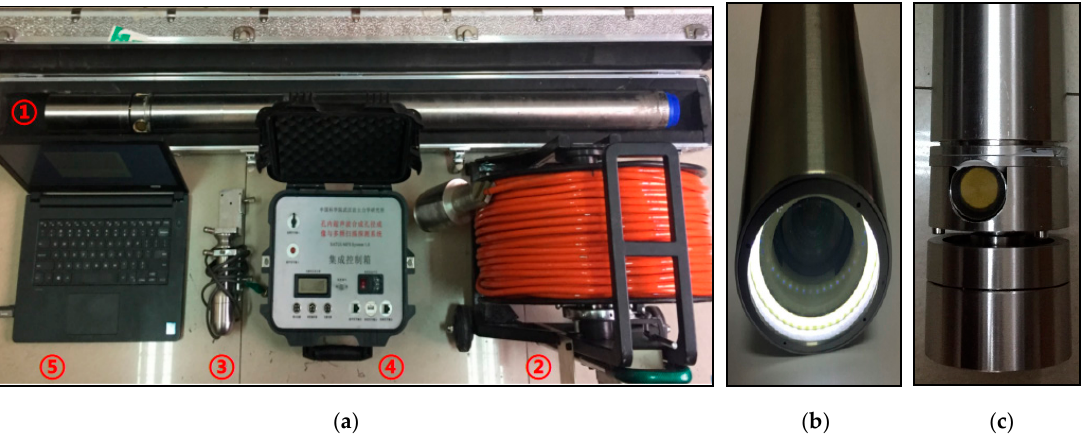
Figure 7. Physical diagram of instrument and equipment. ( a ) Complete system, ( b ) optical imaging measurement module, ( c ) acoustic scanning measurement module.